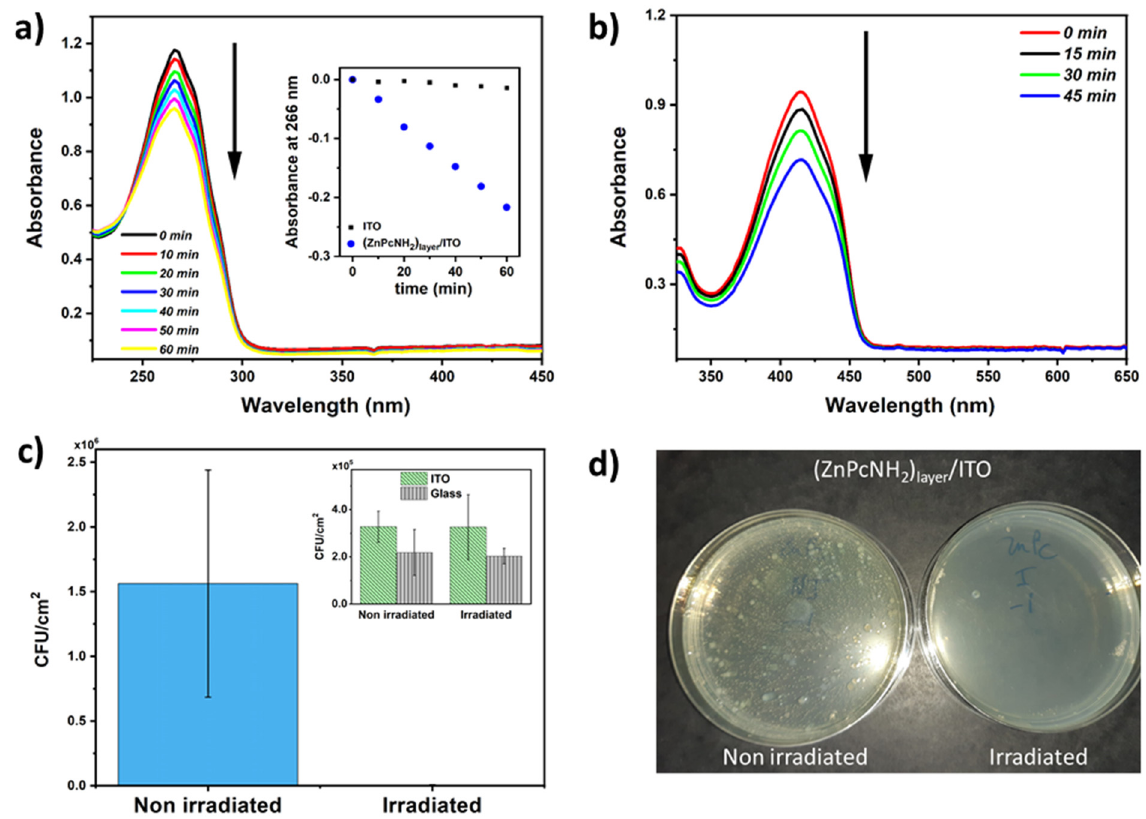
Figure 4. ( a ) UV–Vis spectra of α -terpinene (ACN solution) recorded during illumination of (ZnPcNH 2 ) layer ; inset: a drop in absorbance at 266 nm during illumination of unmodified ITO and (ZnPcNH 2 ) layer /ITO. ( b ) UV–Vis spectra of DPBF (methanol solution) recorded during illumination of (ZnPcNH 2 ) layer . ( c ) Evolution of colony-forming units, CFU/cm 2 (for S. aureus ), at the surface of the non-irradiated and irradiated (ZnPcNH 2 ) layer /ITO; inset: ITO and glass, p < 0.001, n = 4. ( d ) Optical images of S. aureus colonies on Petri dish after 48 h of incubation at 37 °C that adhered to the (ZnPcNH 2 ) layer /ITO surface with and without irradiation.